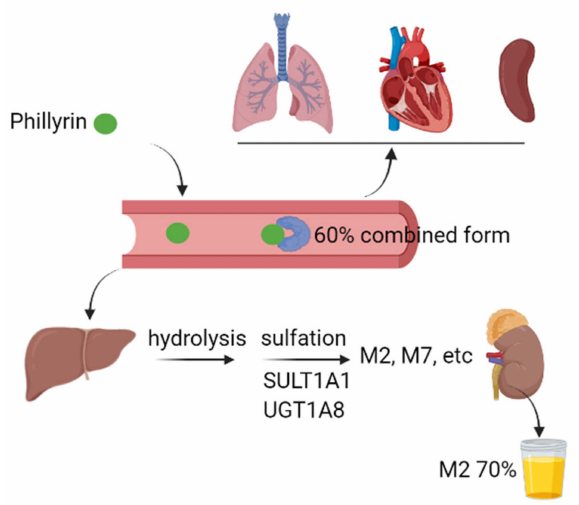
Figure 3. Graphic scheme of pharmacokinetics of phillyrin in vivo. The plasma protein binding rate of phillyrin reached around 60% upon absorption. After absorption, phillyrin was widely distributed in heart, lung, spleen, liver and kidney. In liver, phillyrin underwent extensive hydrolysis and sulfation catalyzed by enzymes such as SULT1A1 and UGT1A8. Most of the parent component and its metabolites were mainly secreted via urine. SULT1A1: sulfotransferase 1A1, UGT1A8: UDP-glucuronosyltransferase 1A8. (This figure was created with